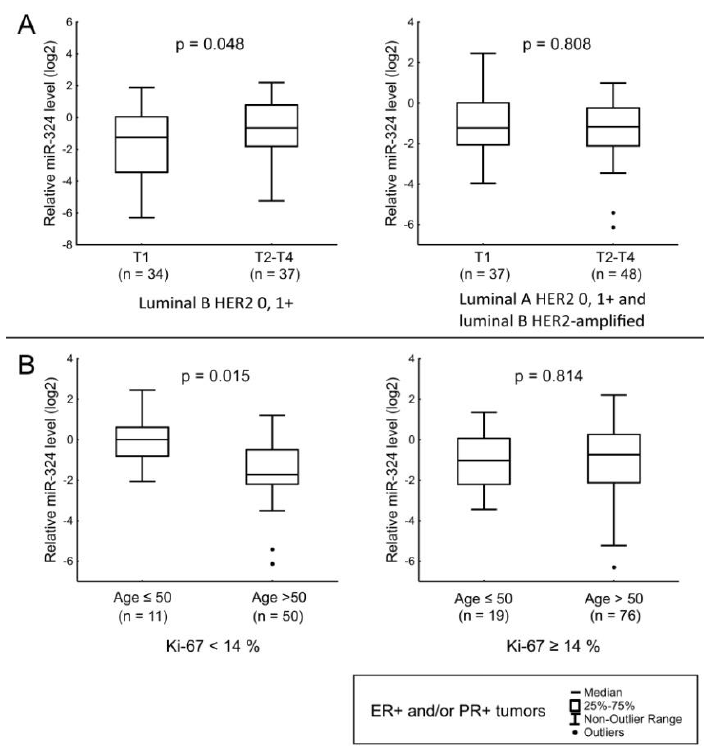
Figure 6. The comparison of miR-324 expression between different cancerous tissue groups: ( A ) relation of miR-324 level with the T stage in luminal B HER2-non-amplified tumors (left), relation of miR-324 level with the T stage in luminal A and luminal B HER2-amplified tumors (right); ( B ) relation of miR-324 level with age of patients in tumors with Ki-67 < 14% (left), relation of miR-324 level with age of patients in tumors with Ki- 67 ≥ 14% (right). The Y axis presents the expression level ( log 2 2 –ΔΔCt ); the results were normalized to the control (normal tissue). We observed that the level of miR-423 is reduced in tumor tissues of patients with LNM. This decrease was not observed only for patients with luminal B HER2 0 BC (Figure 7).